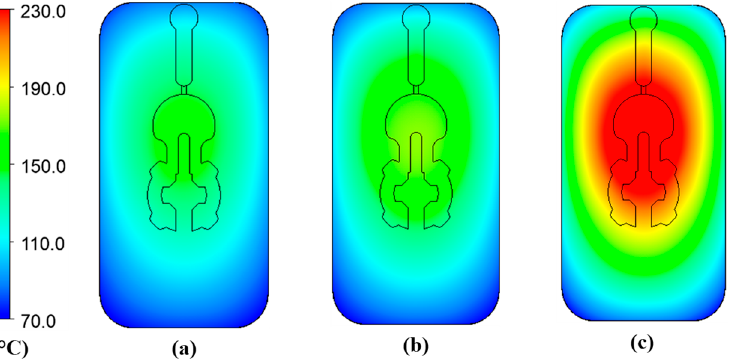
Figure 14. Temperature distribution of stamp with a gas temperature of ( a ) 200 °C, ( b ) 300 °C, and ( c ) 400 °C.